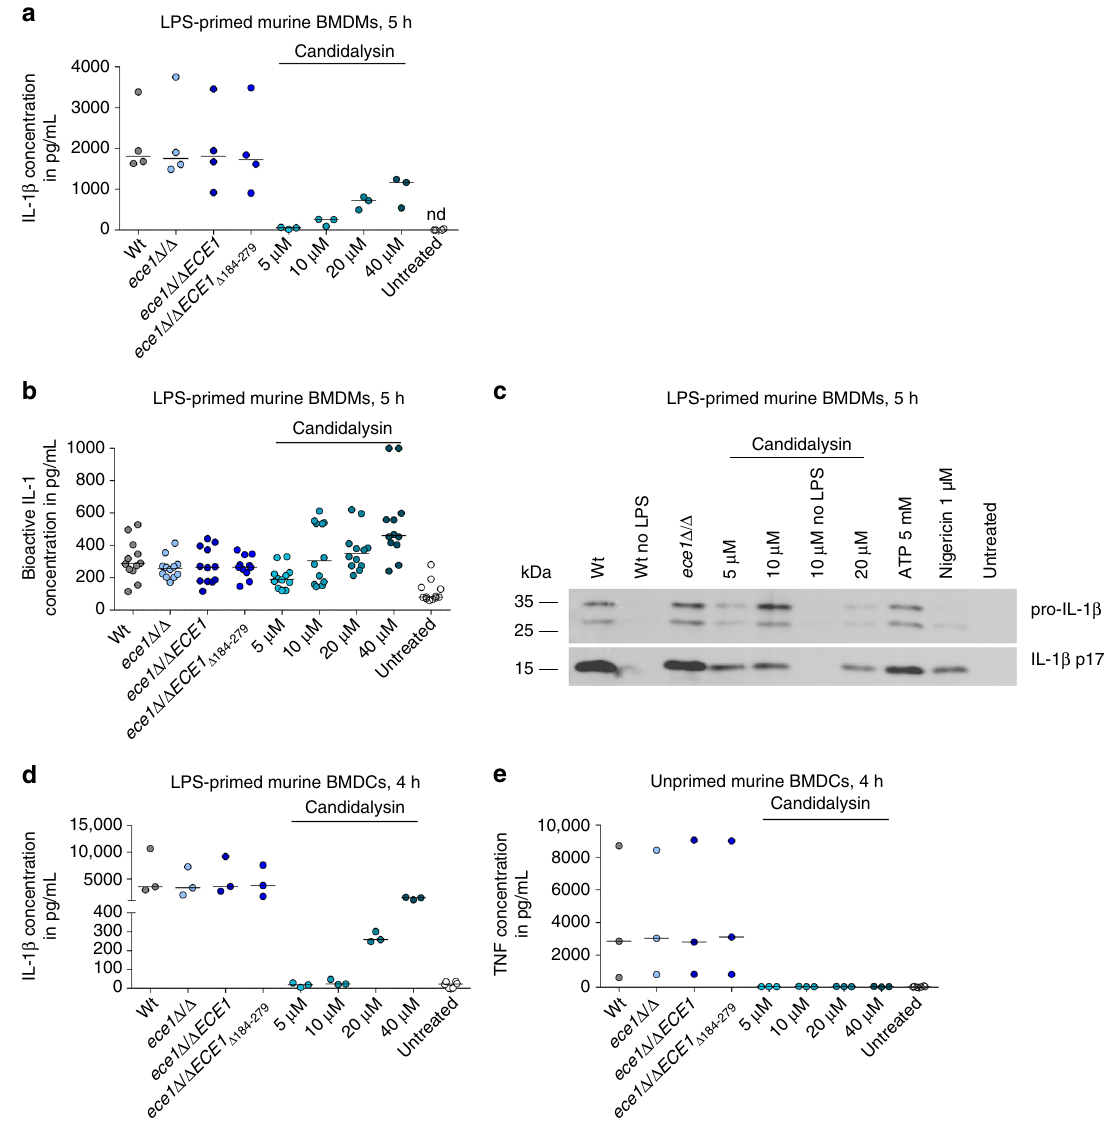
Fig. 4 Candidalysin induces IL-1 β release in murine mononuclear cells. a IL-1 β release measured by ELISA in culture supernatants LPS-primed mBMDMs infected with C . albicans Wt, re-integrant ( ece1 Δ / Δ + ECE1 ) or mutant strains ( ece1 Δ / Δ , ece1 Δ / Δ + ECE1 Δ 184 – 279 ) (MOI 6) or co-incubated with synthetic Candidalysin for 5 h. b Levels of bioactive IL-1 measured in culture supernatants of LPS-primed mBMDMs that were infected with C . albicans Wt, re- integrant ( ece1 Δ / Δ + ECE1 ) or mutant strains ( ece1 Δ / Δ , ece1 Δ / Δ + ECE1 Δ 184 – 279 ) (MOI 6) or co-incubated with synthetic Candidalysin. Bioactive IL-1 was quanti fi ed by stimulation of EL4.NOB-1 cells culture supernatants and correlation of the secreted murine IL-2 to a concentration range of recombinant human IL-1 β . c The presence of processed IL-1 β (p17) detected by western blotting in the supernatant of LPS-primed or unprimed (no LPS) mBMDMs that were infected with C . albicans Wt re-integrant ( ece1 Δ / Δ + ECE1 ) or mutant strains ( ece1 Δ / Δ , ece1 Δ / Δ + ECE1 Δ 184 – 279 ) (MOI 10) or co-incubated with synthetic Candidalysin for 5 h. A representative image of three independent experiments or donors is shown. d IL-1 β and e TNF levels measured by ELISA in culture supernatants of LPS-primed or unprimed mBMDCs respectively, that were infected with C . albicans Wt, re-integrant ( ece1 Δ / Δ + ECE1 ) or mutant strains ( ece1 Δ / Δ , ece1 Δ / Δ + ECE1 Δ 184 – 279 ) (MOI 5) or co-incubated with synthetic Candidalysin for 5 h (mBMDMs) or 4 h (mBMDCs). Secreted IL-1 β ( a , d ) and TNF ( e ) were determined by ELISA. Values are represented as scatterplots and the median of at least three different replicates ( n ≥ 3). nd